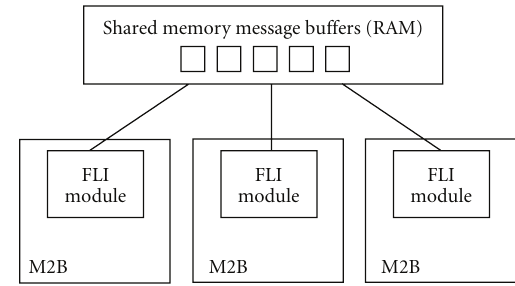
Figure 5: Multiple FSB FLI Modules can independently access the message bu ff ers in shared memory during